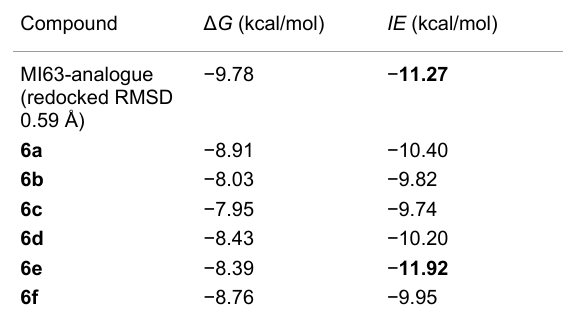
Table 3: Estimated lowest binding energy based on the largest num- ber in cluster ( Δ G ) and intermolecular energy ( IE